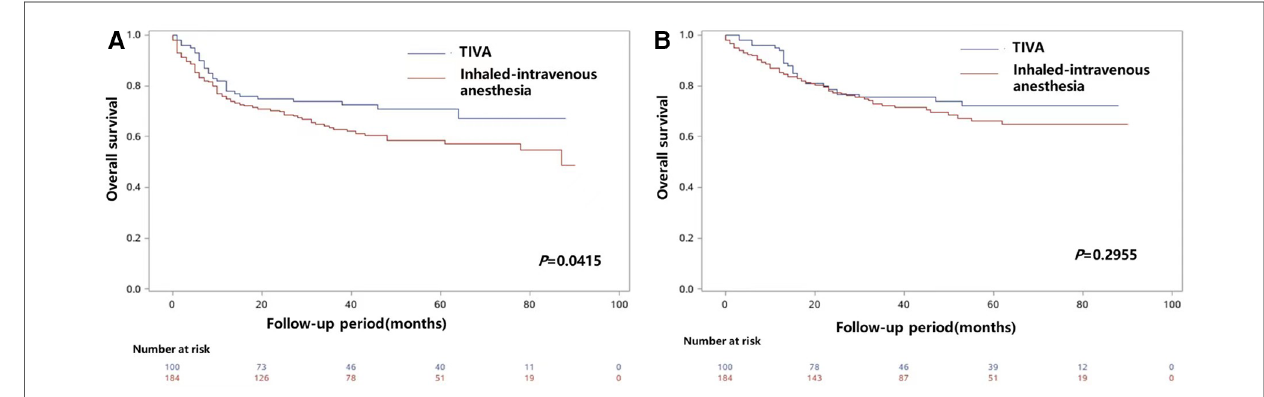
FIGURE 1 K-M curves of the overall survival (OS) ( A ) and recurrence/metastasis-free survival ( B ) of patients underwent different anesthesia